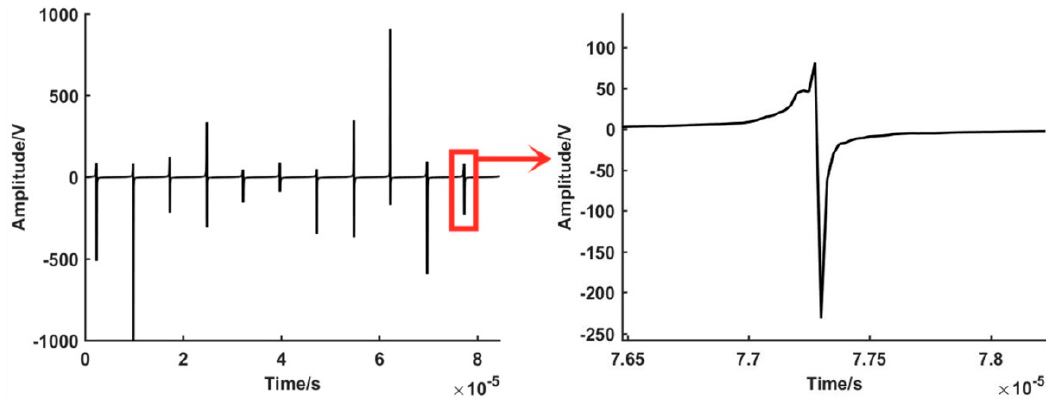
Figure 7. Overflowing handling of the tangent value of encoder output.